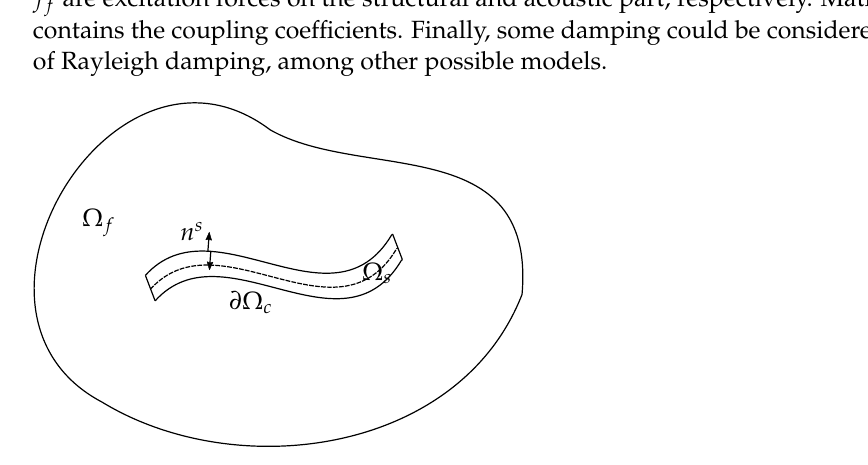
Figure 2. Beam fully immersed in the fluid. The beam element has been implemented as two node straight line element. On the beam’s axis, it is assumed that there is continuity of